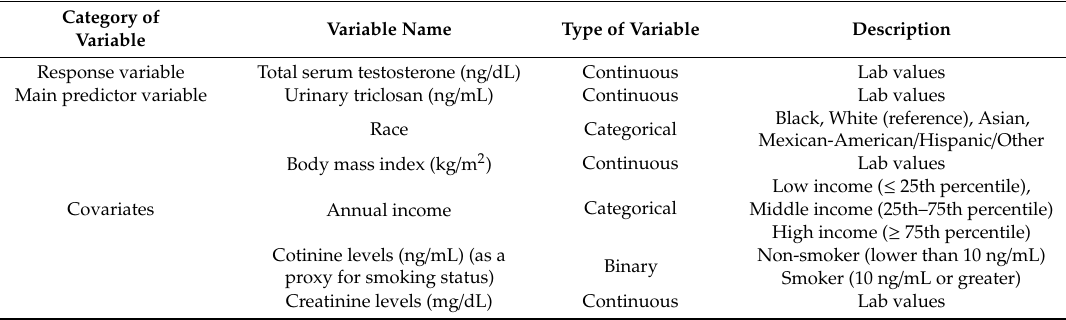
Table 1. Description of study